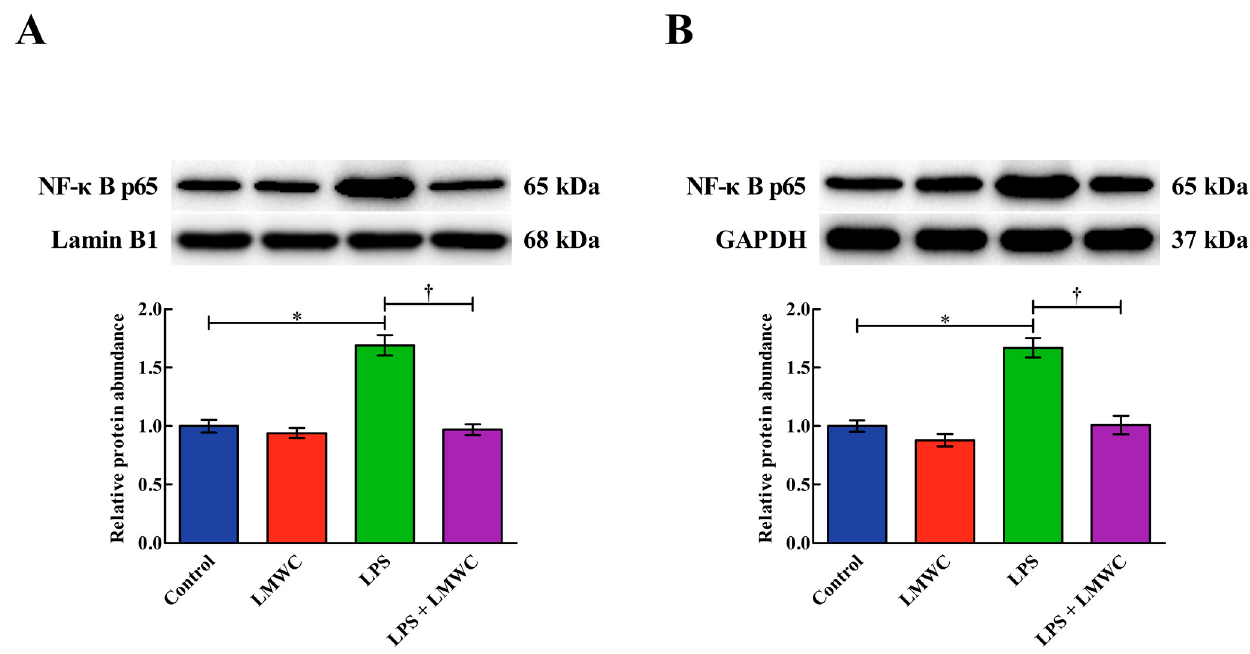
Figure 9. Effects of LMWC on the nuclear and cytoplasmic abundance of NF- κ B p65 in LPS-treated IPEC-J2 cells. ( A ) Nuclear NF- κ B p65: intra-nuclear nuclear factor- κ B p65. ( B ) Cytoplasmic NF- κ B p65: cytoplasmic nuclear factor- κ B p65. Cells were pretreated with LMWC (400 µ g/mL) for 2 h, followed by cotreatment with LPS (5 µ g/mL) for another 6 h. Data are presented as the mean ± standard error ( n = 4). * Means significant difference compared with the control group ( p < 0.05). † Means significant difference compared with the LPS group ( p < 0.05).